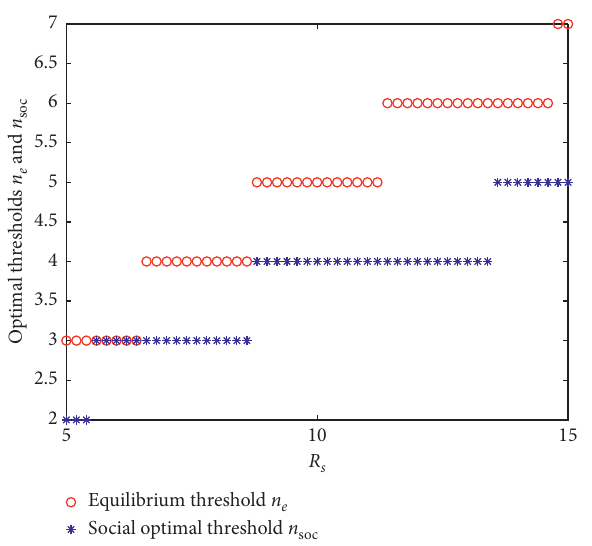
Figure 2: Equilibrium and social optimal thresholds versus R ( C � 3 , R � 4 ) . f